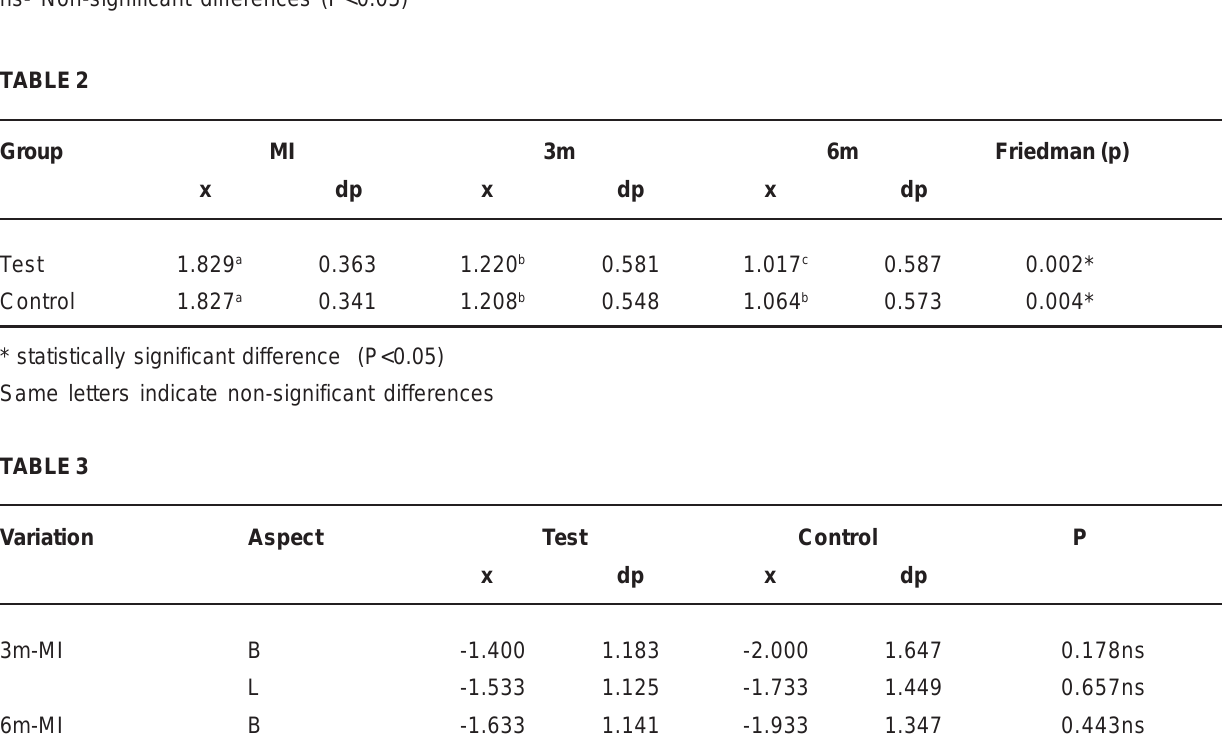
ns-Non-significant differences